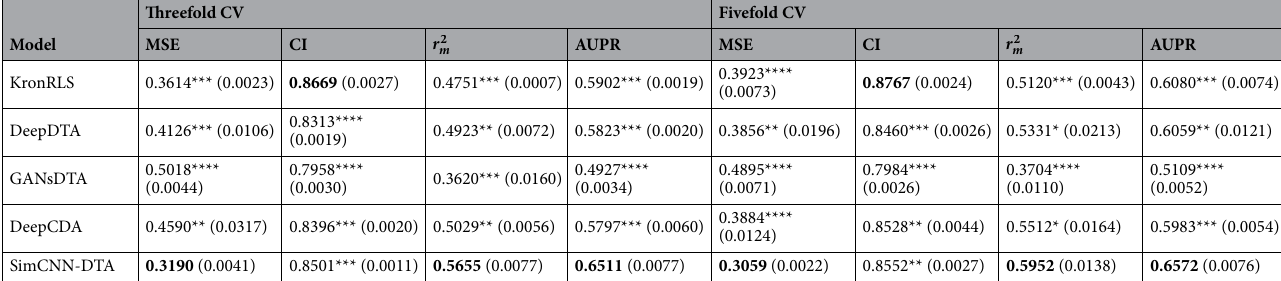
Table 2. Comparison of five prediction models via threefold and fivefold cross validations on the Davis dataset.